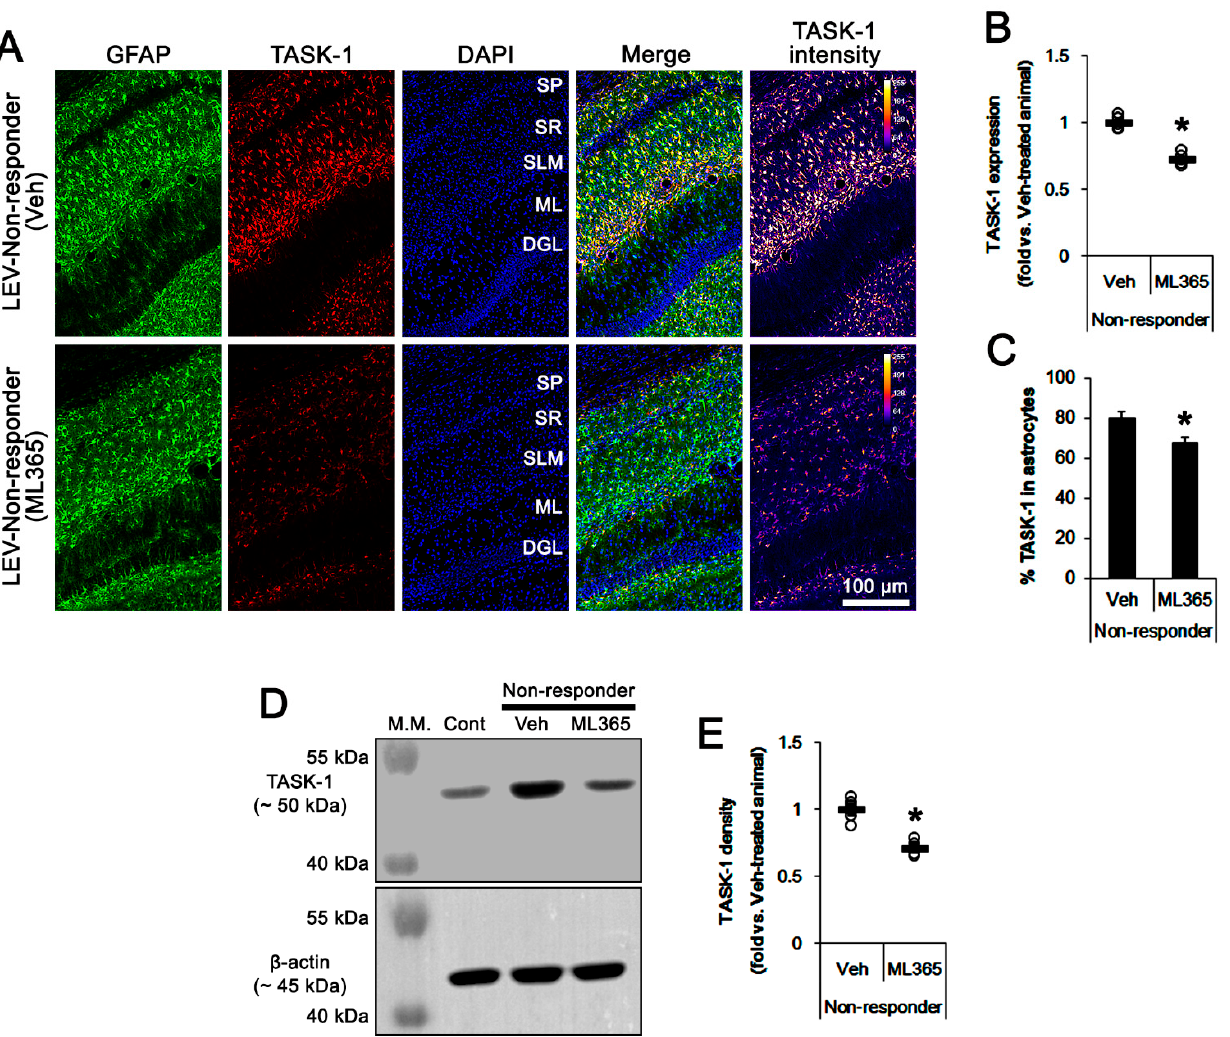
Figure 5. The effect of ML365 on TASK-1 expression in non-responders to levetiracetam (LEV). As compared to the vehicle (Veh), ML365 reduces TASK-1 expression in CA1 astrocytes within the hippocampus of non-responders. ( A ) Representative photos of TASK-1 expression in the hippocampus (SP, stratum pyramidale; SR, stratum radiatum; SLM, stratum lacunosum-moleculare; ML, molecular layer of the dentate gyrus; DGL, dentate granule cell layer). ( B ) Quantitative analyses of the effect of ML365 on TASK-1 expression based on immunohistochemical data. Open circles indicate each individual value. Horizontal bars indicate the mean value. Error bars indicate SEM ( * , p < 0.05 vs. vehicle-treated animals; Student’s t -test). ( C ) Quantitative analyses of the effect of ML365 on the fraction of TASK-1 positive astrocytes in total astrocytes ( * , p < 0.05 vs. control animals; Student’s t - test; error bars, SEM). ( D ) Representative images for Western blot of TASK-1 protein expression in the hippocampal tissues. ( E ) Quantification of TASK-1 levels based on Western blots ( * , p < 0.05 vs. vehicle-treated animals; Student’s t -test).